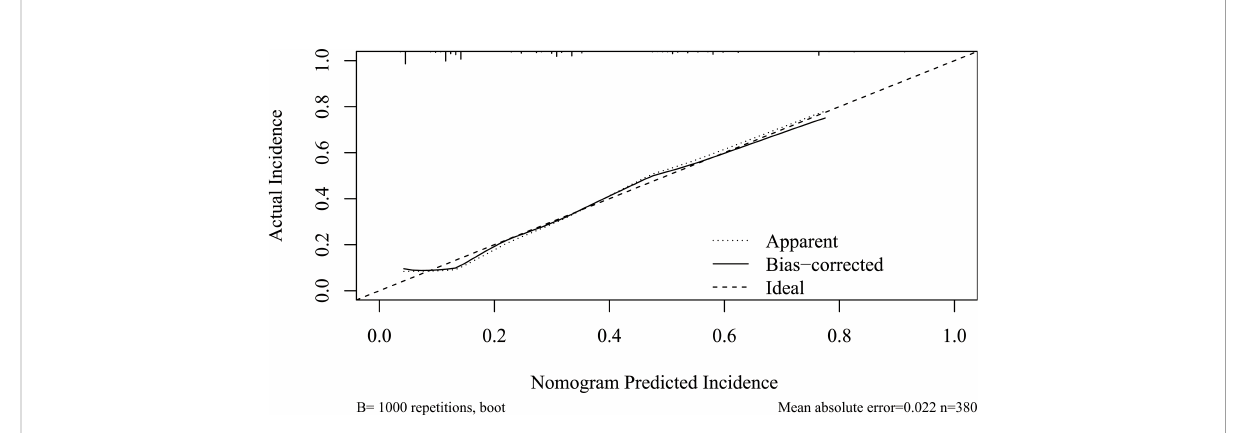
FIGURE 5 Calibration plot of the nomogram. Calibration plot of the nomogram predicting CR-POPF. The x -axis represents the nomogram-predicted survival, and the actual survival is plotted on the y -axis. The apparent incidence of CR-POPF, the ideal incidence, and the bias-corrected incidence were shown as different lines. CR-POPF, clinically relevant postoperative pancreatic fi stula.